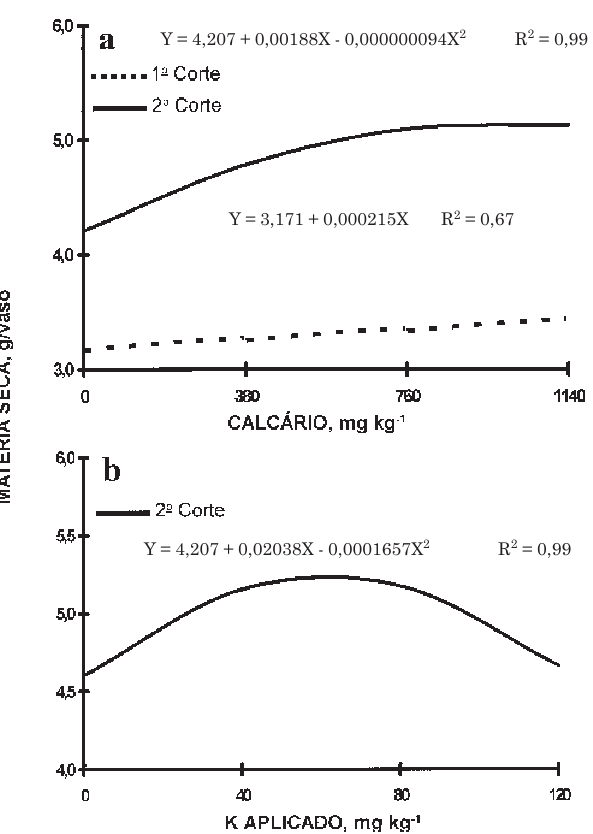
Figura 1. Produção de matéria seca da parte aérea da alfafa, em função das doses de calcário (a) e de potássio